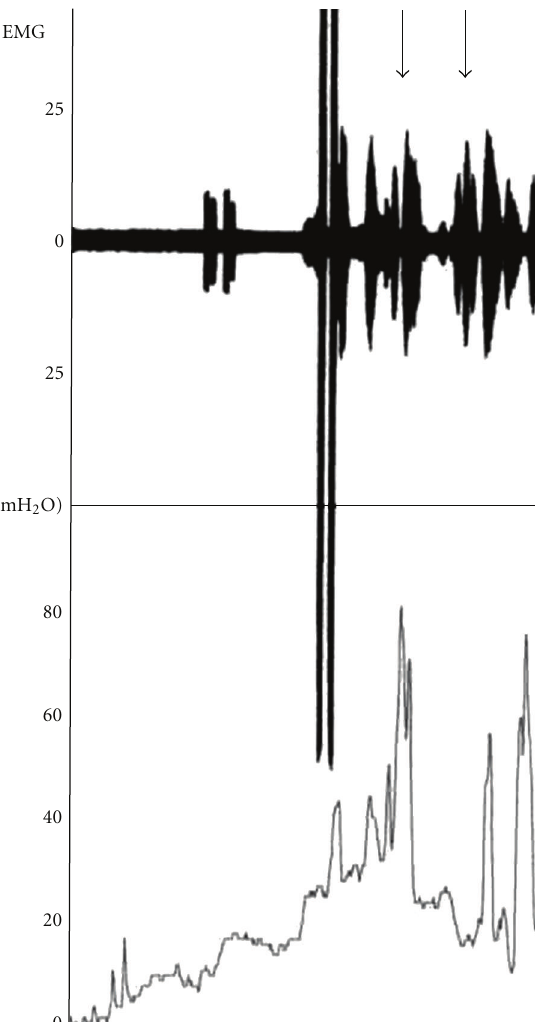
Figure 3: Electromyography (EMG) showed impaired compliance with detrusor overactivity associated with low-volume urine. Increased sphincter activity consistent with detrusor sphincter dyssynergia (arrow). Detrusor leak point pressure was 50cmH 2 O, and maximum intravesical pressure was 80 cmH 2 O. Maximum bladder capacity was 170 mL with no